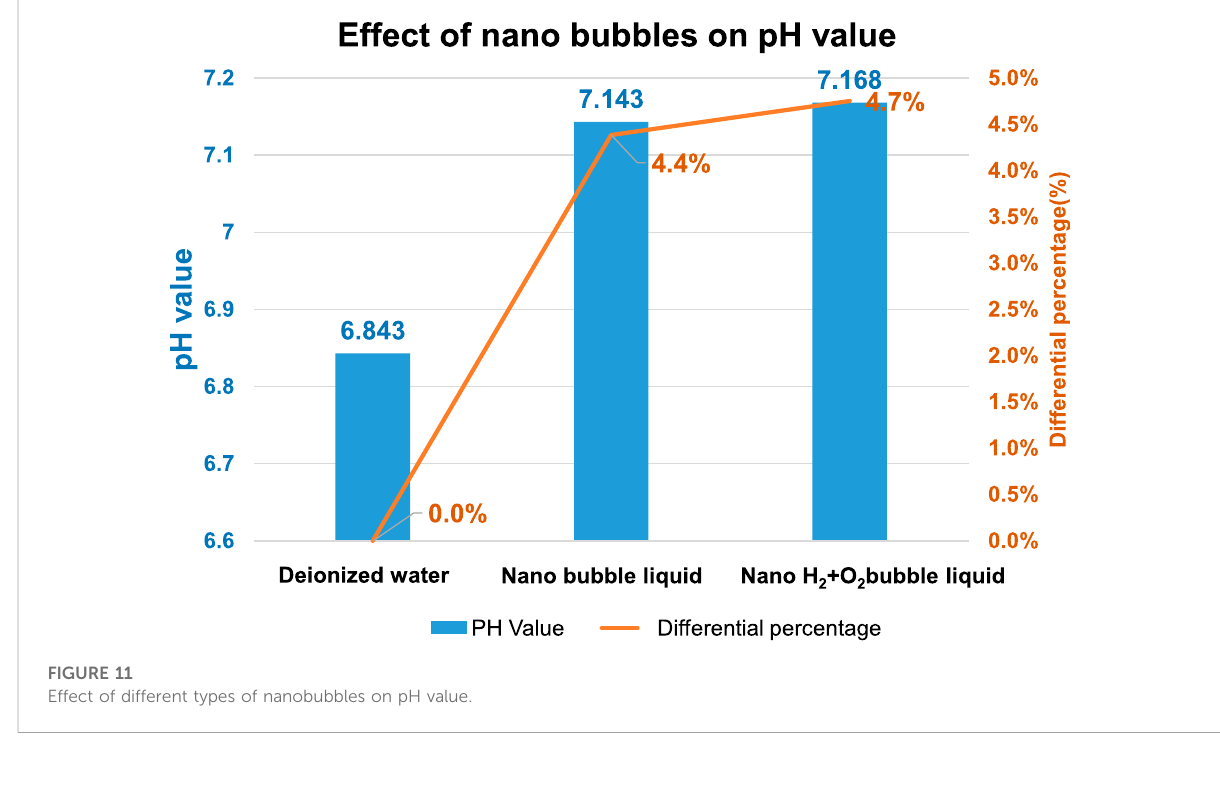
FIGURE 11 Effect of different types of nanobubbles on pH value.